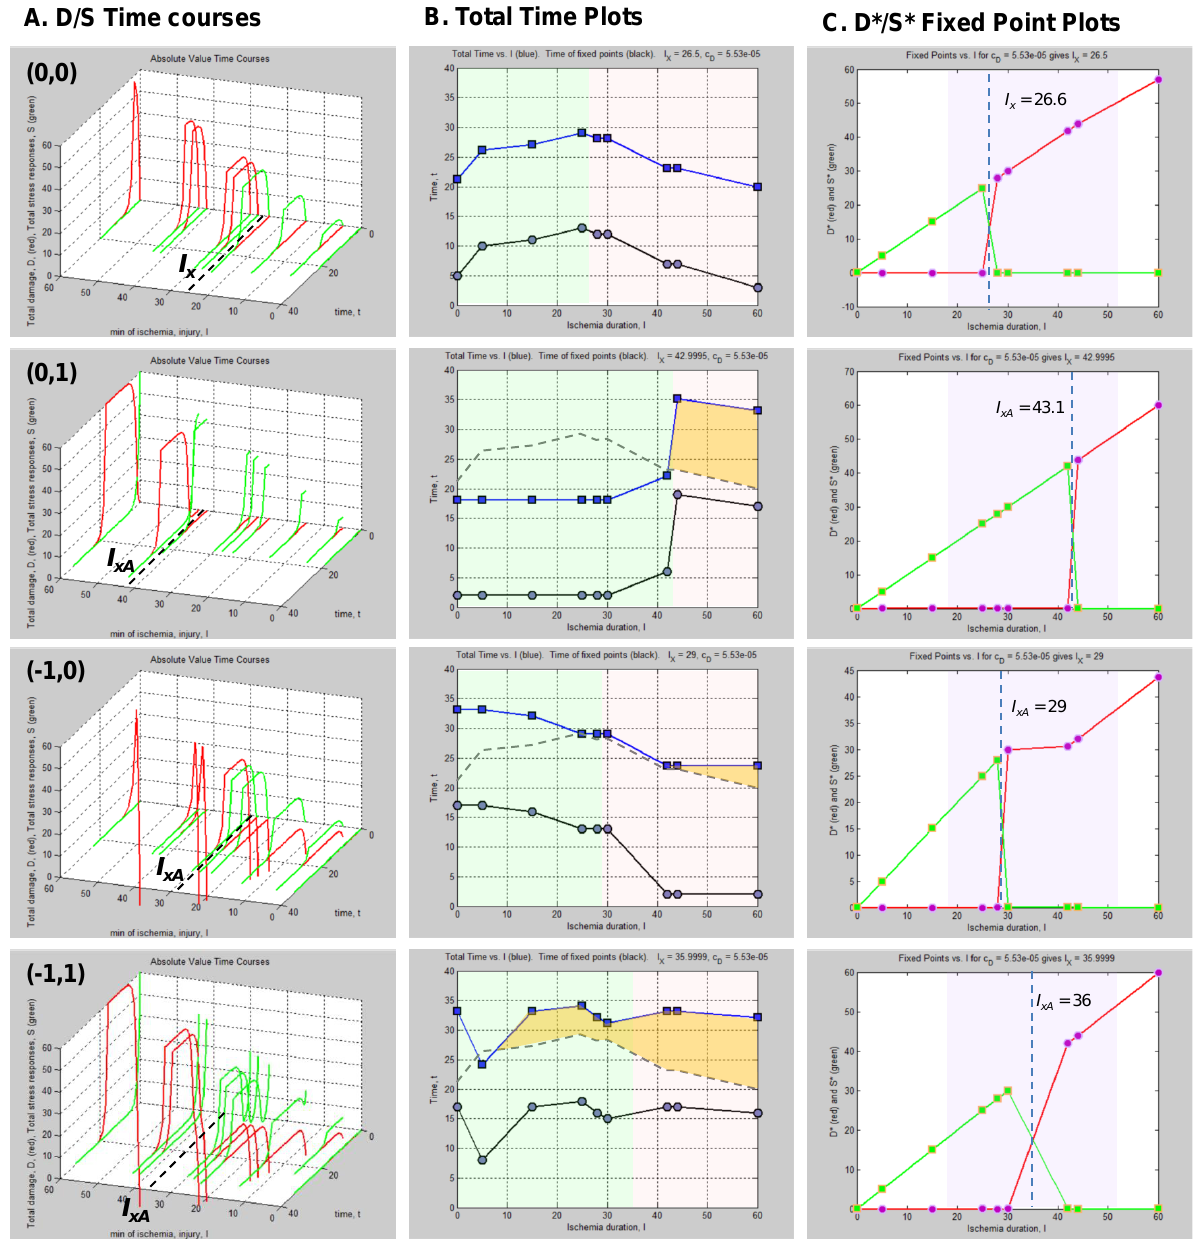
Figure 13. Simulations showing effect of neuroprotective pre-treatments on the 10% CBF injury course. Rows 1–4 are initial conditions ( D , S ) of (0, 0), (0, 1), (−1, 0) and (−1, 1), 0 0 respectively. ( A ) D (red) and S (green) time courses under specified initial conditions. ( B ) Total time plots: total durations (blue) and attractor state durations (black) vs. I . The total duration from the ( D , S ) = (0, 0) are reproduced as dashed gray line on other plots. 0 0 Orange area marks difference between the current and ( D , S ) = (0, 0) total duration 0 0 curves. Green areas correspond to survival time courses, and red areas to death time courses. ( C ) Fixed point plots. Purple rectangle marks full extent of the bistable region, which does not change under altered initial conditions. I is the cross-over amount of I , x calculated by Equation (5). I is the “apparent I ” and is where the D* and S* fixed point xA x curves cross when ( D , S ) ≠ (0, 0 0